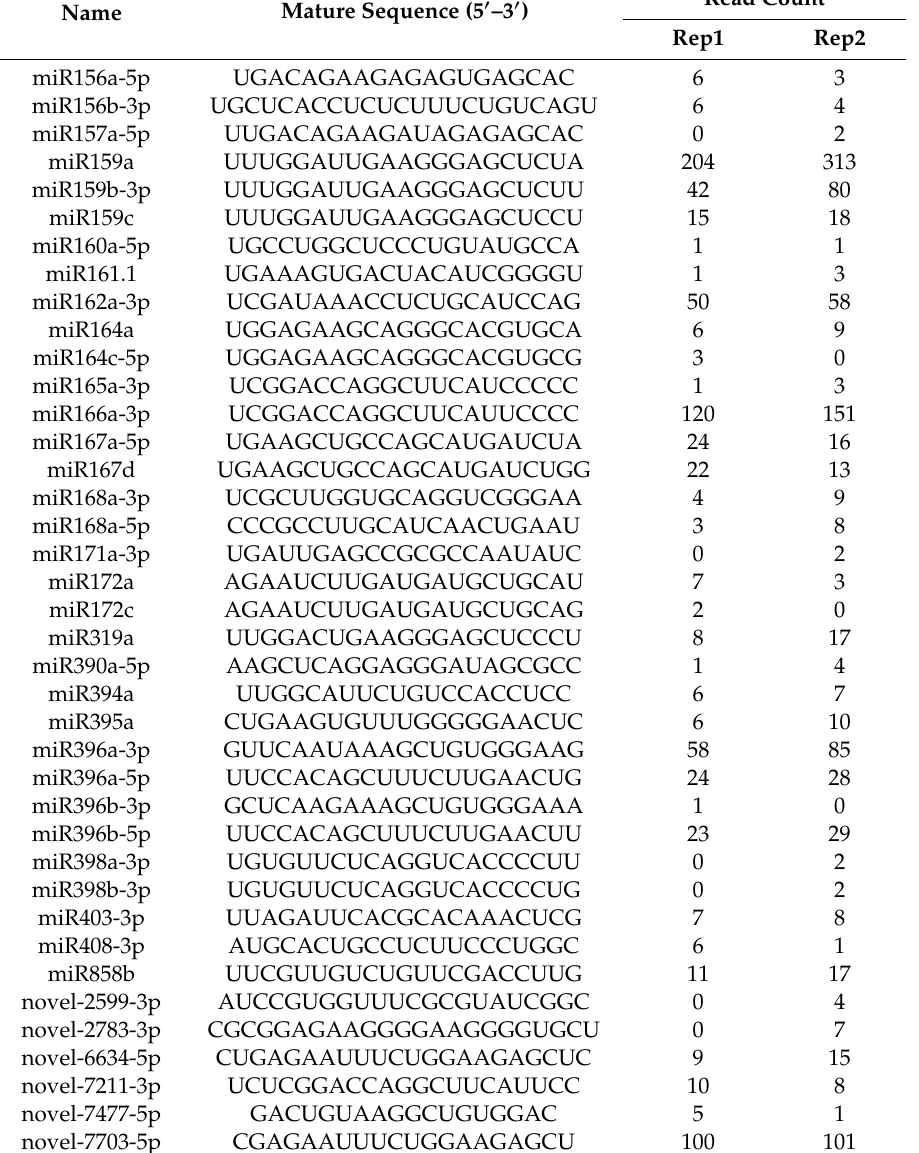
Table 1. Plant-derived microRNAs (miRNAs) identified in the hemolymph of P. xylostella . (cid:48) –3 (cid:48) Name Mature Sequence (5